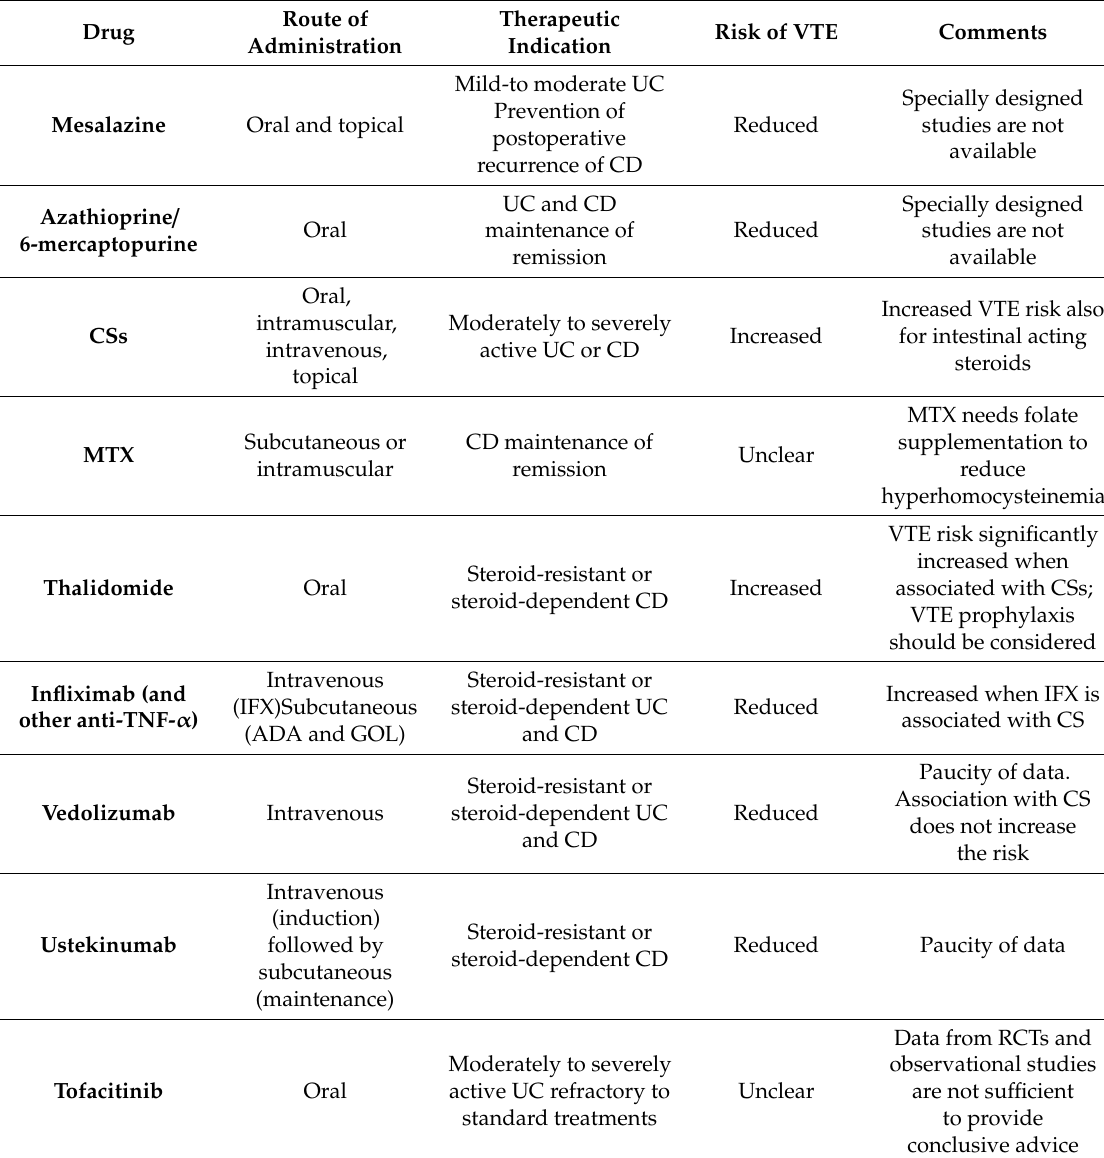
Table 3. Therapies for patients with inflammatory bowel disease and risk of venous thromboembolism.